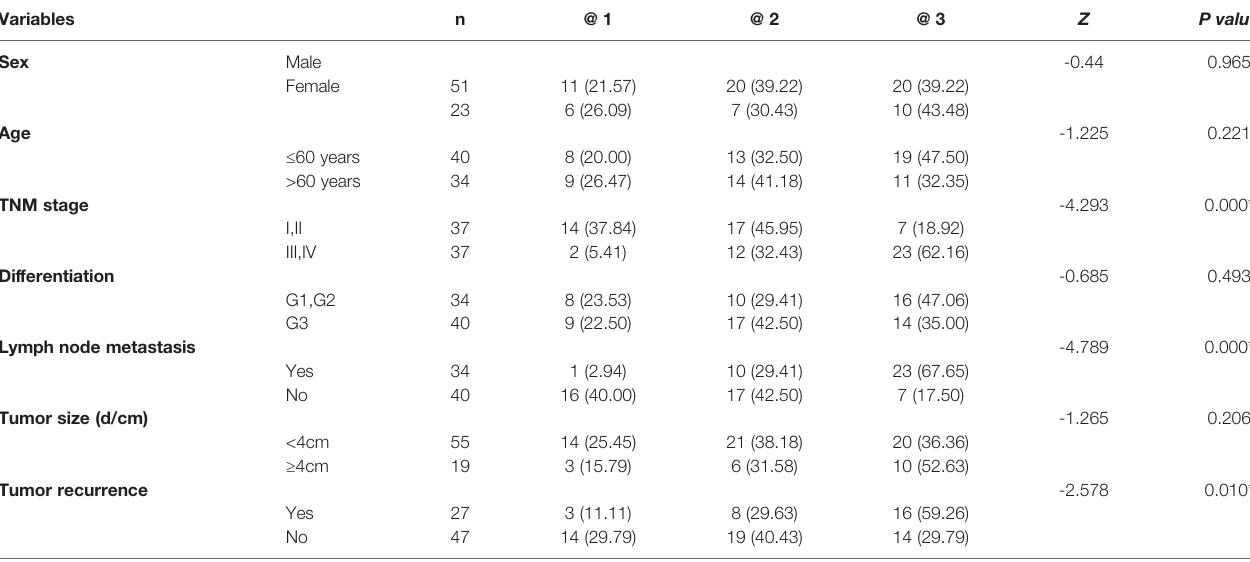
TABLE 1 | The relationship between the expression of Chemerin, CD15 + TANs density and clinicopathological parameters in OSCC (x / %).